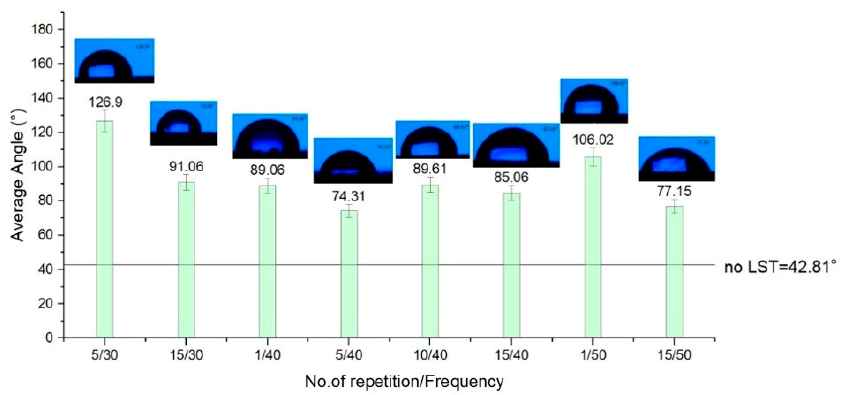
Figure 13. Average contact angle for design type C.